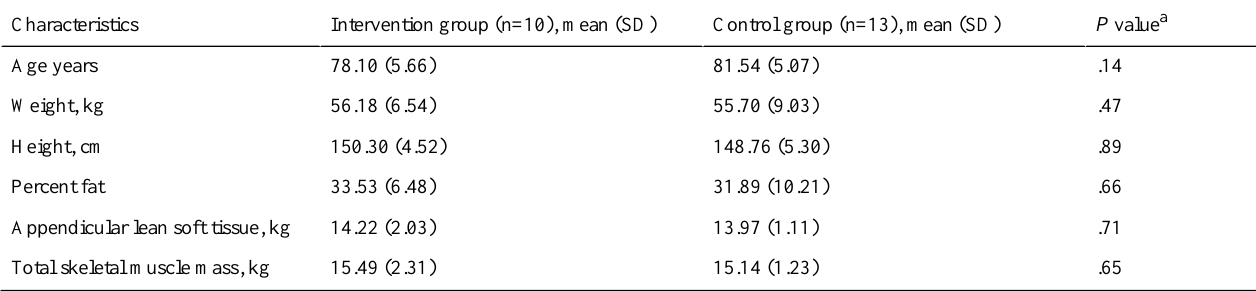
Table 1. Baseline physical characteristics.